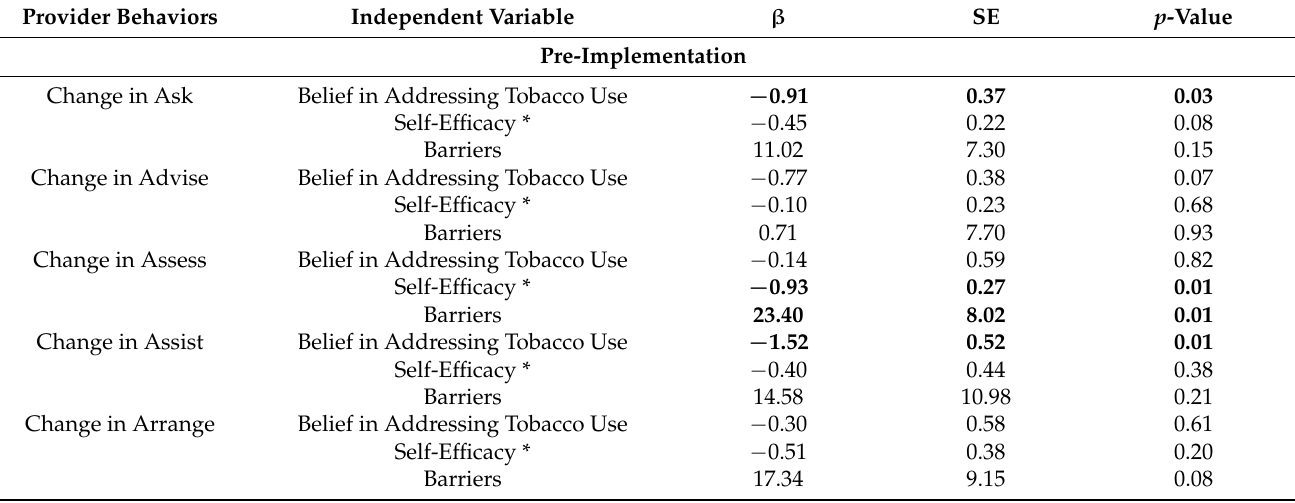
Table 2. Associations between organizational-level factors and changes in the use of the five A’s for smoking cessation from before to after a comprehensive tobacco-free workplace